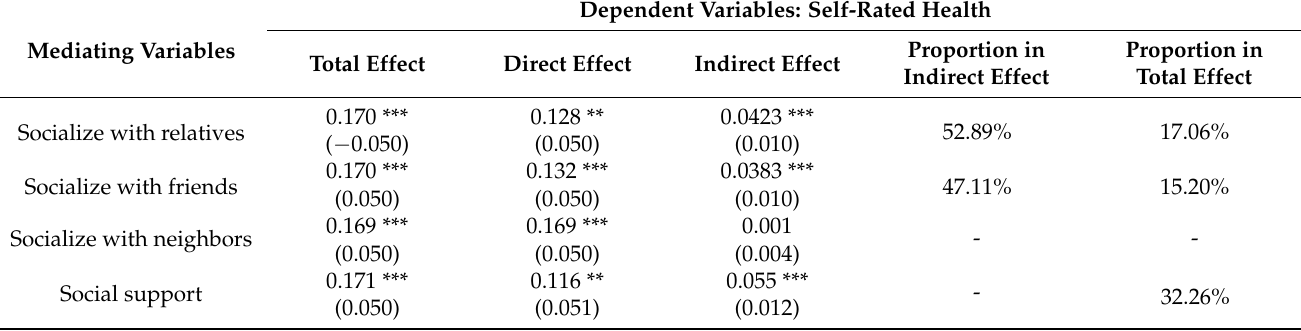
Table 7. Effect decomposition and comparison of KHB